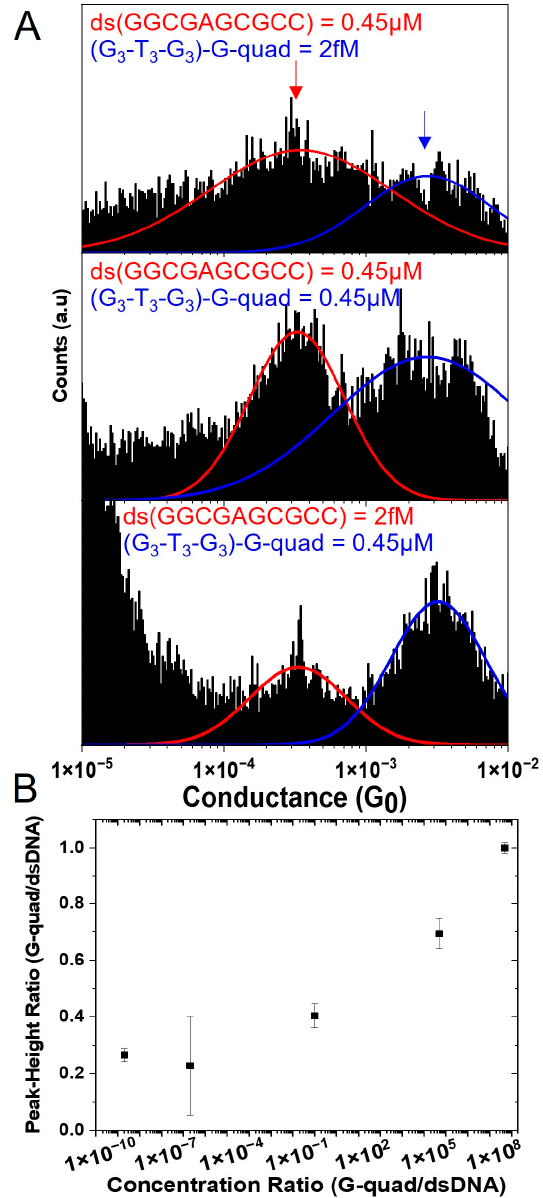
Figure 6. Sensitivity of the SMBJ approach to the concentration of different conformations. ( A ) Representative conductance histograms of 0.45 µM ds(GGC GAG CGCC), 2 fM (G 3 -T 3 -G 3 )-G-quad (top panel), 0.45 µM ds(GGC GAG CGCC), 0.45 µM (G3-T3-G3)-G-quad (middle panel), 2 fM ds(GGC GAG CGCC), and 0.45 µM (G3-T3-G3)-G-quad (bottom panel). ( B ) Dependence of the peak-height ratio on the concentrations ratio of the G-quad and dsDNA. Vertical error bars represent the standard error of the mean of the average peak-height ratio from two independent measurements.